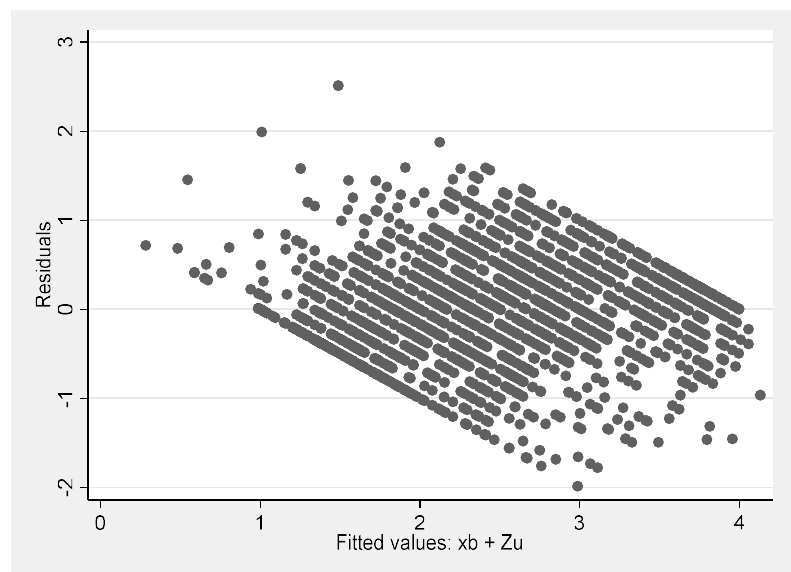
Figure A2. Homoscedasticity. Figure A2.